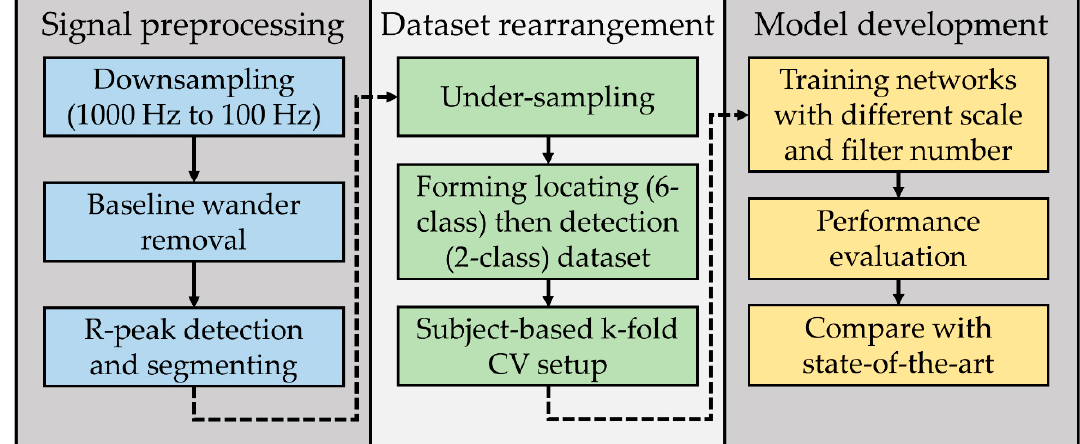
Figure 3. Block diagram of the proposed method, including signal preprocessing, dataset rearrangement, and model development.